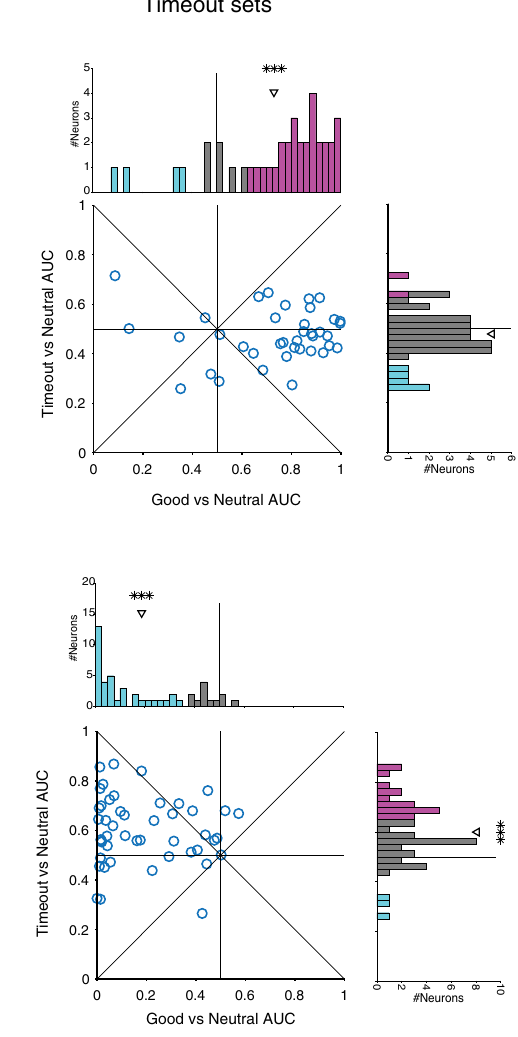
Fig. 5 | Lack of correlation between aversive and value signals in vlPFC and cdlSNr for saline and timeout associated objects which had weak salience. Marginal and joist distribution of aversive AUC (>0.5, left: saline>neutral, right: timeout > neutral) vs value (>0.5, good>neutral) AUC across all neurons in vlPFC (top row) and in cdlSNr (bottom). (Saline set, vlPFC Pearson ’ s ρ = − 0.09, P =0.49, value AUC=0.72, t 56 =6.9, P =4e-9, aversive AUC=0.47, t 56 = − 2.6, P =1e-2, cdlSNr: